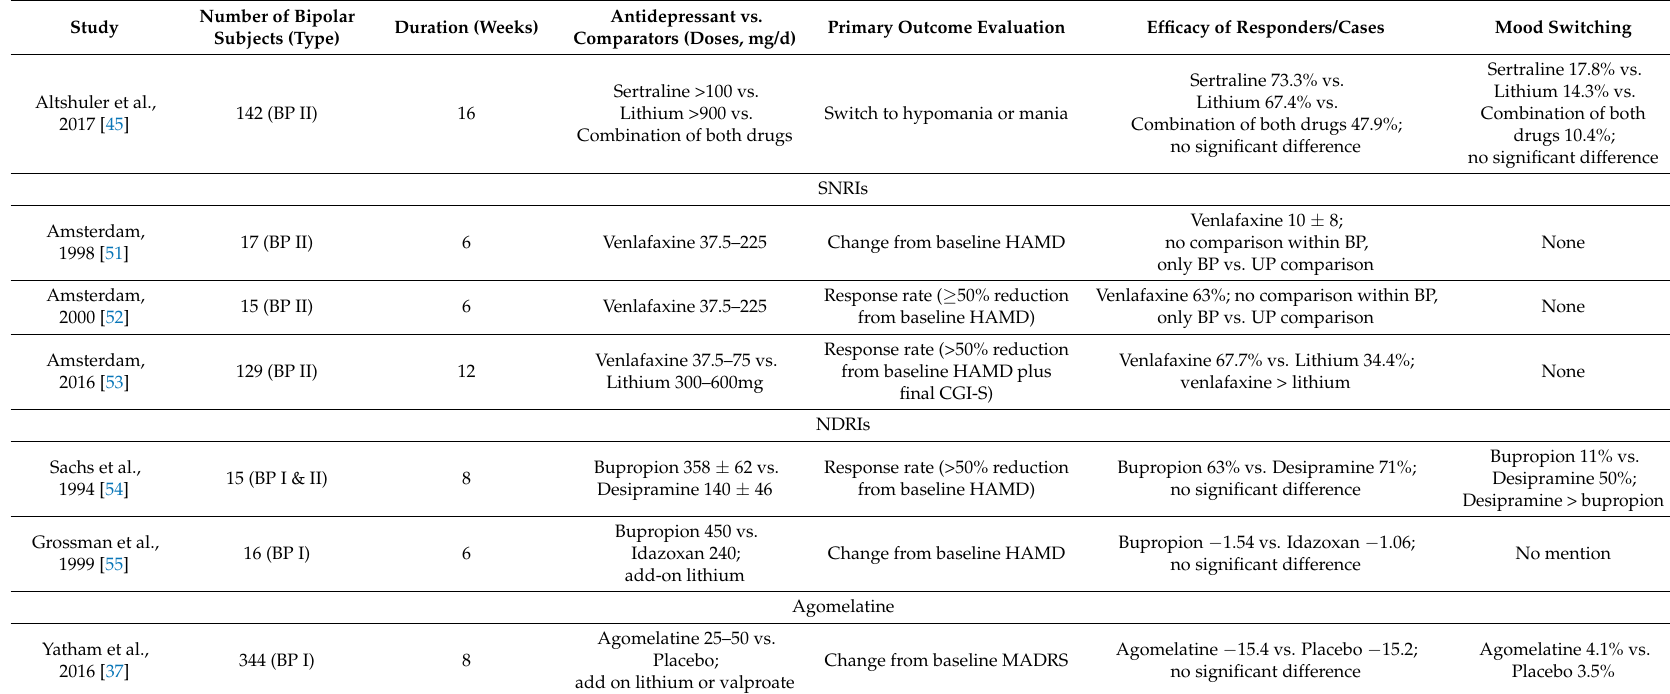
(Abbreviations: BDI, Beck Depression Inventory; HAMD, ; CGI-I, clinical global impression severity-improvement; MADRS, Montgomery-Asberg depression rating scale; OFC olanzapine-fluoxetine combination; IDS, Inventory of depressive symptomatology; CGI-BP, clinical global impression-bipolar version, YMRS, young mania rating scale; GAF, global assessment of functioning